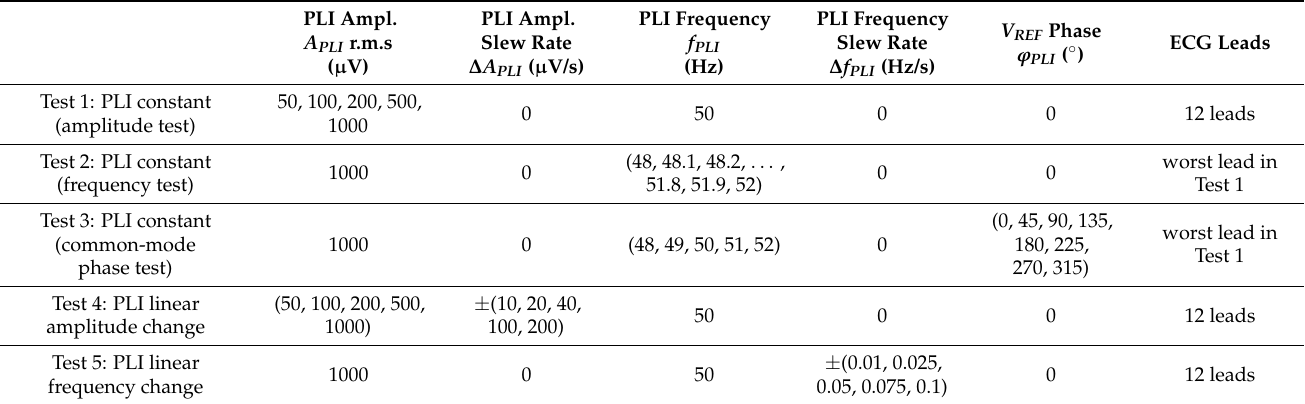
Table 2. Simulation parameters of PLI with duration of 10 s for five test scenarios with PTB Diagnostic ECG database.